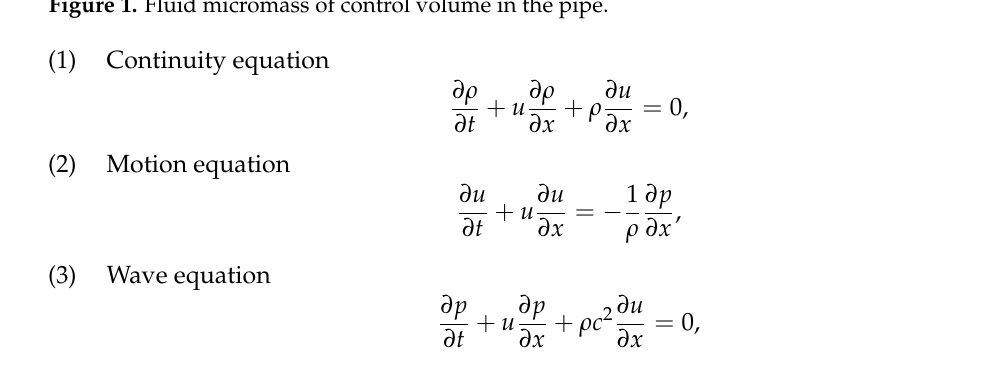
Figure 1. Fluid micromass of control volume in the pipe.